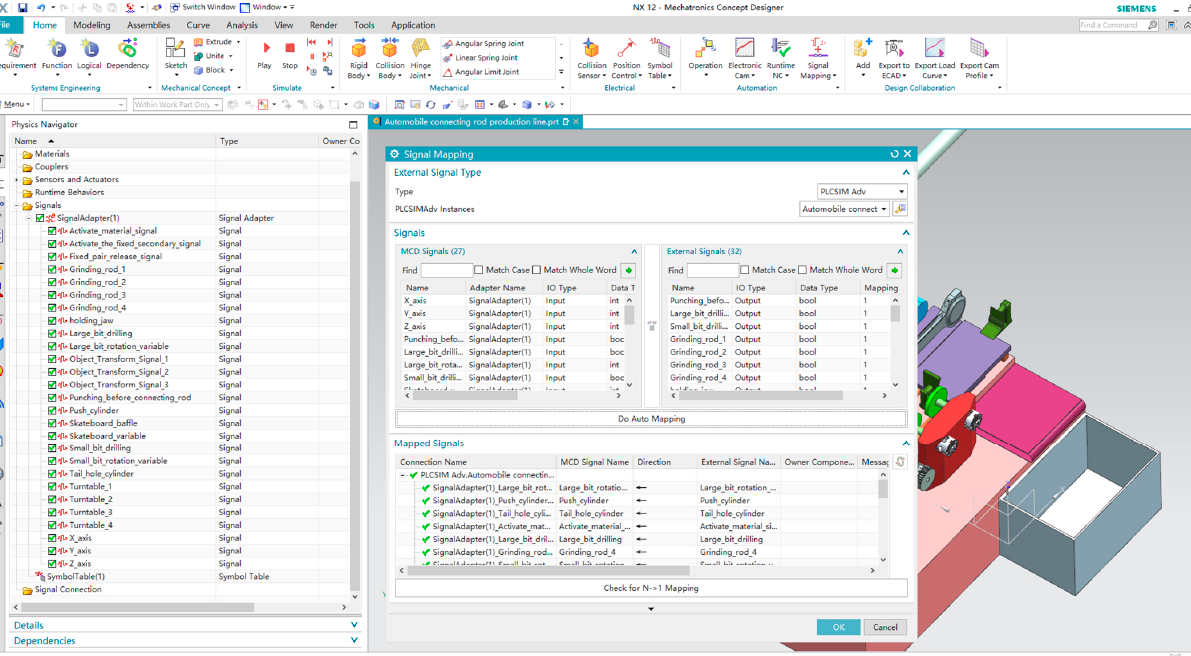
Figure 17. Signal mapping of the first part of the processing area.